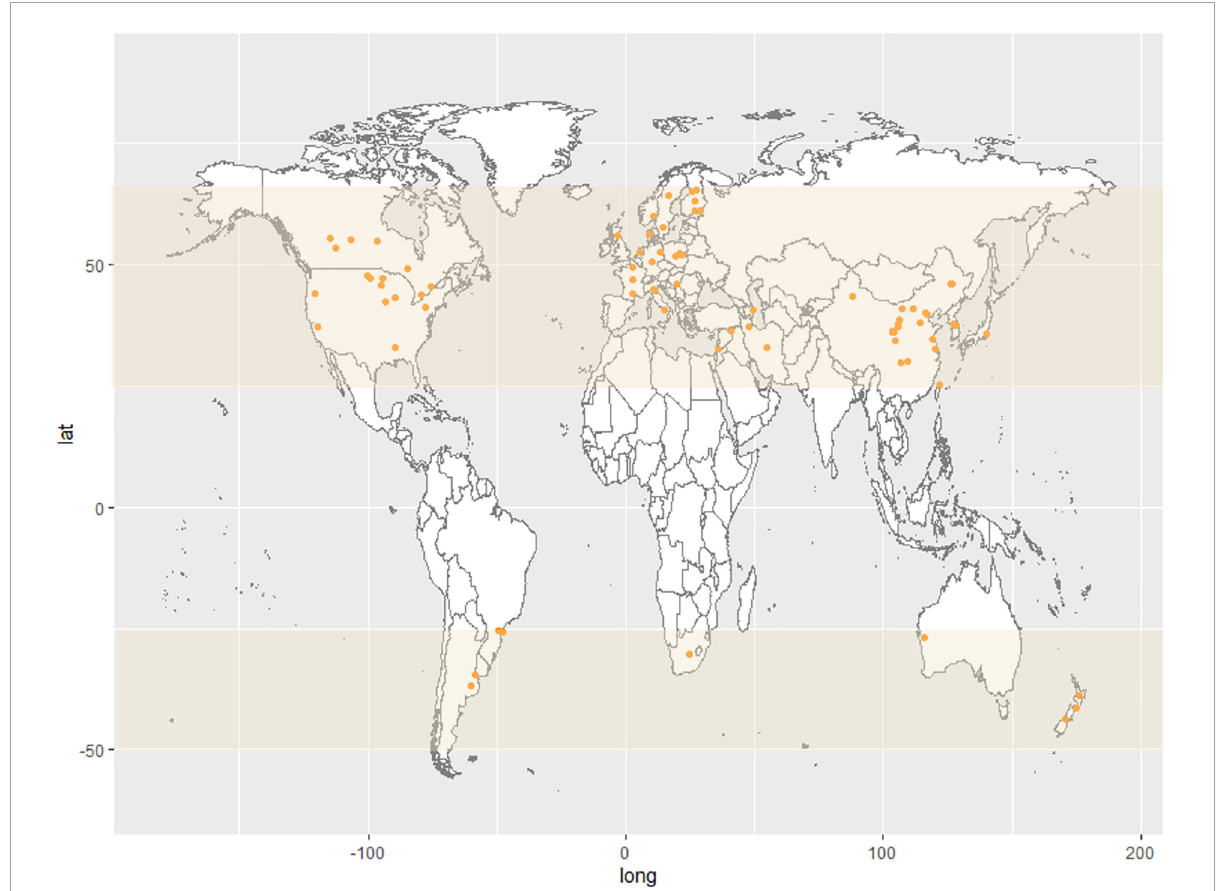
FIGURE3 Map showing the global distribution (orange dots) of plant hosts with reported F. tricinctum infection. The distribution is limited to the temperate zone (covered in light